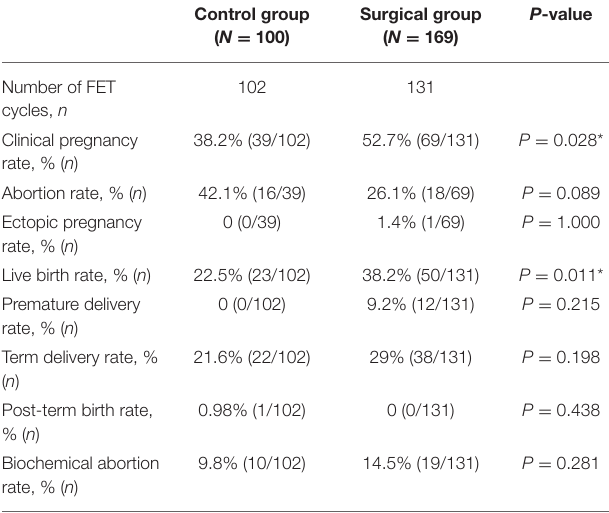
TABLE 4 | Reproductive outcomes per FET